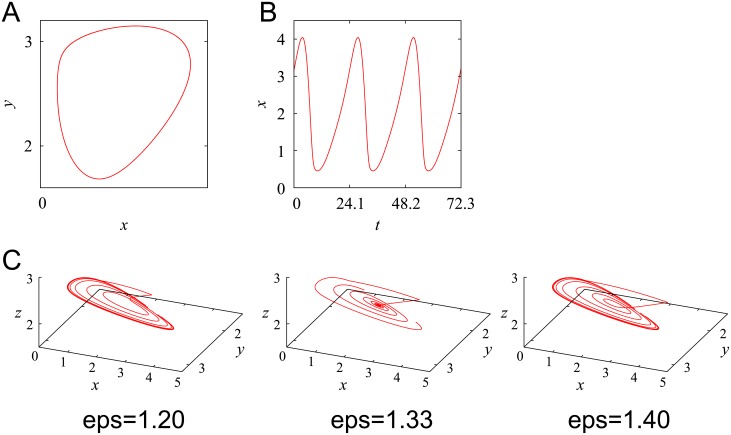
Computational simulation of the limit cycle and relaxation processes after perturbation without noise.(A) Limit cycle in (X, Y) plane and (B) time series of X(t) for the unperturbed system (Eq (1)). (C) Trajectories for 0 ≤ t ≤ 164.3 in (X, Y, Z) space, in which perturbation was given during 13.3 < t < 14.3. Parameter values were the same as those employed in Locke et al. [36]: v1  =  6.8355, n  =  5.6645, K1  =  2.7266, v2  =  8.4297, K2  =  0.2910, k3  =  0.1177, v4  =  1.0841, K4  =  8.1343, k5  =  0.3352, v6  =  4.6645, K6  =  9.9849, k7  =  0.2282, v8  =  3.5216, K8  =  7.4519, vc  =  6.7924, Kc  =  4.8283, K  =  1, L = 0.